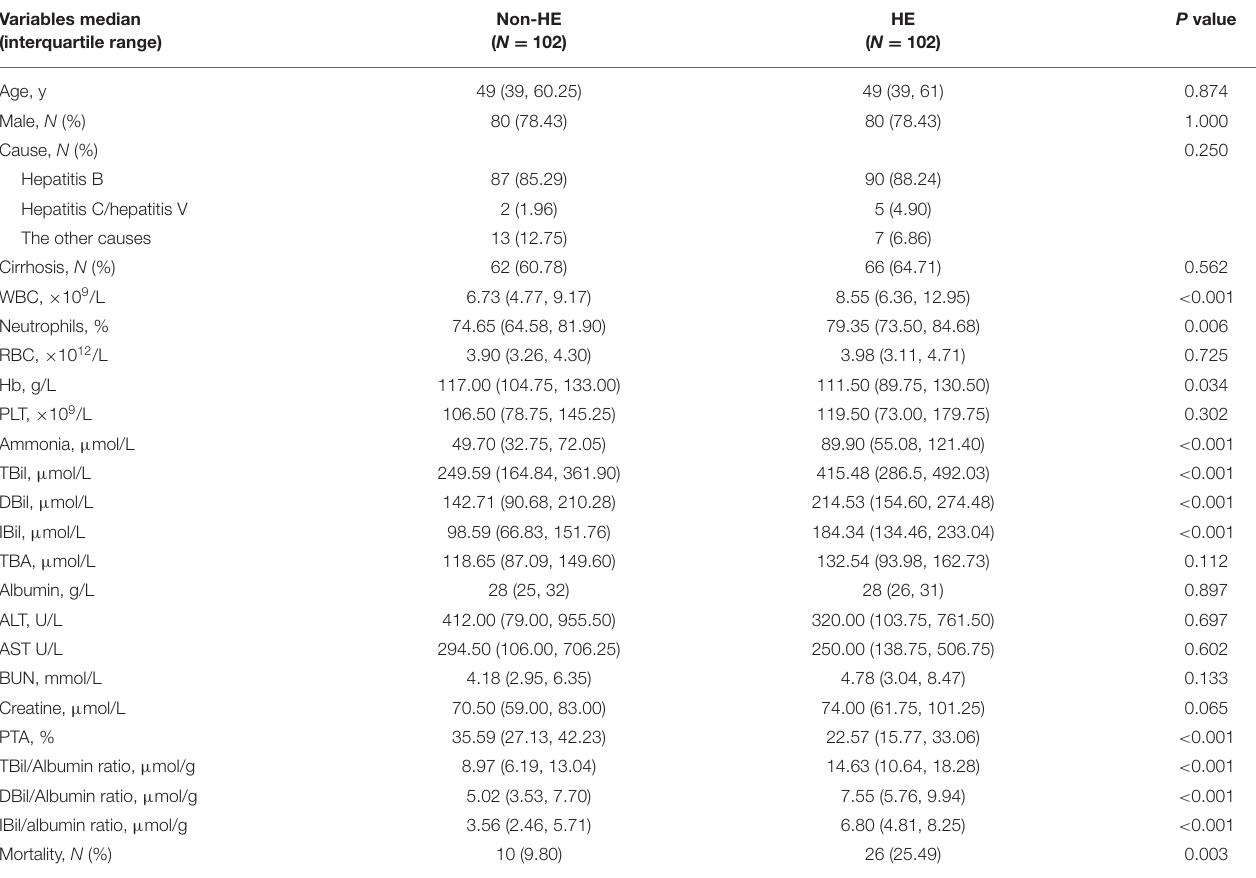
TABLE 1 | Comparisons of characteristics of patients with and without HE. Variables median (interquartile